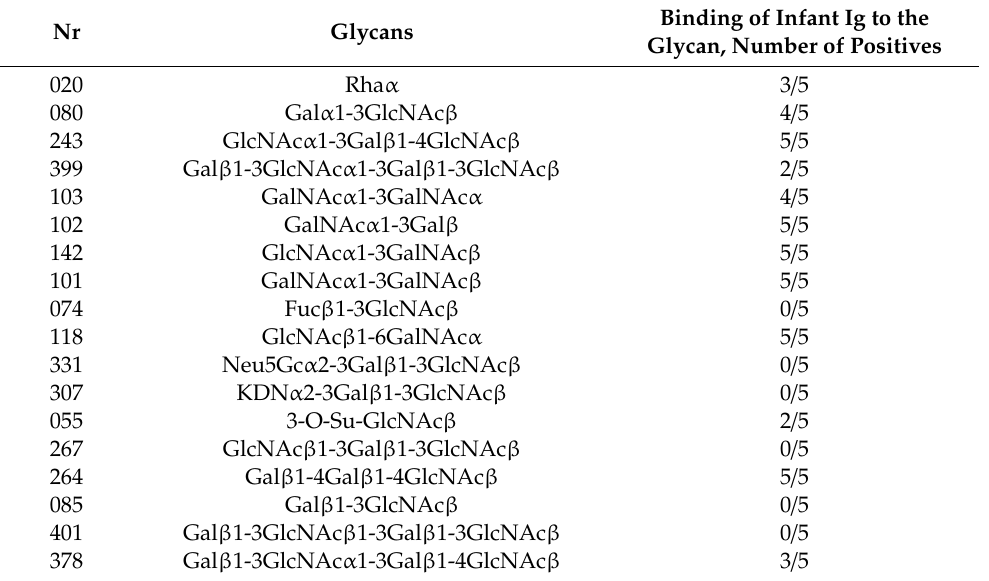
Table 2. The frequency of occurrence in the five infants studied of those antibodies (IgM) that showed a high signal level in the cohort of adult donors. Right column: the number of infants (out of a total of five) with significant binding; glycans related to Le C family are shown in bold. Fm, formyl